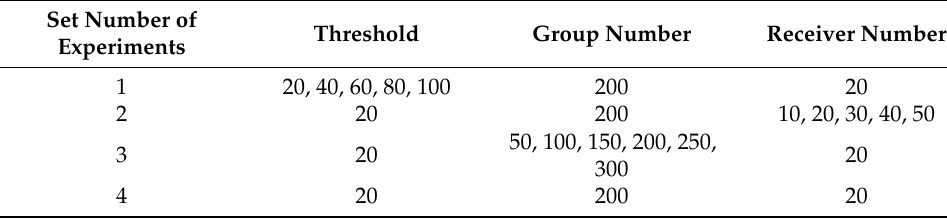
Table 2. Parameters of each set of